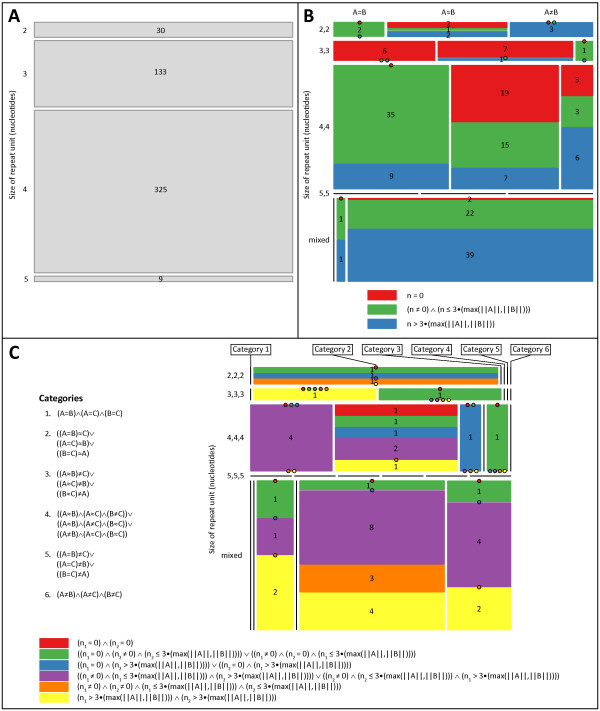
Mosaic plots describing microsatellites with (A) one, (B) two or (C) three separate STR regions. In the mosaic plots [117,118], tiles represent categories of microsatellites, and the area of each tile is proportional to the number of microsatellites in the corresponding category. For loci with two or more STR regions, loci are first grouped by the relationships between the repeat units in their STR regions - identical ("A=B"), similar ("A≈B"; 1 bp difference between their sequences), or different by more than 1 bp ("A≠B") - and by the sizes of those repeat units (i.e. di-, tri-, tetra-, or penta-nucleotide, with "mixed" referring to loci whose STR regions are comprised of repeat units of different sizes). Each group of loci is partitioned into distinct categories based on the distance (in nucleotides) separating their STR regions, as described below the plot, and each category is represented in a different color. Black bars represent groups that contain no loci. Filled circles represent those categories within a group that contain no loci. For microsatellites with two STR regions, n represents the number of nucleotides separating the first and second STR regions. For microsatellites with three STR regions, n1 and n2 respectively represent the numbers of nucleotides separating the first and second, and the second and third, STR regions. Key: ∧, and; ∨, or; ||A||, length of A.